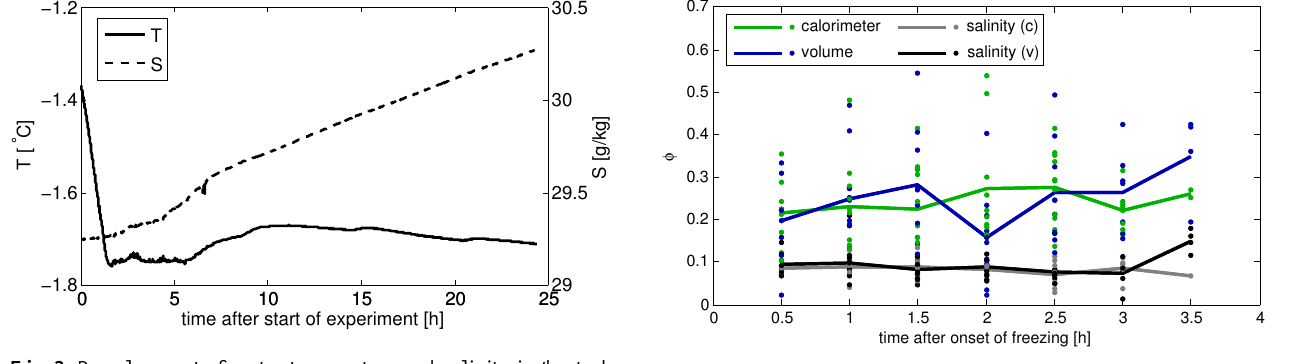
Fig. 4. Temporal evolution of the solid fraction from single mea- surements (dots) and as an average over all experiments with waves and with current and wind (lines) analysed with different methods. At each time of measurement two samples were taken, the first one analysed with the calorimeter and the salinity (c) method, the sec- ond one analysed with the volume and the salinity (v)